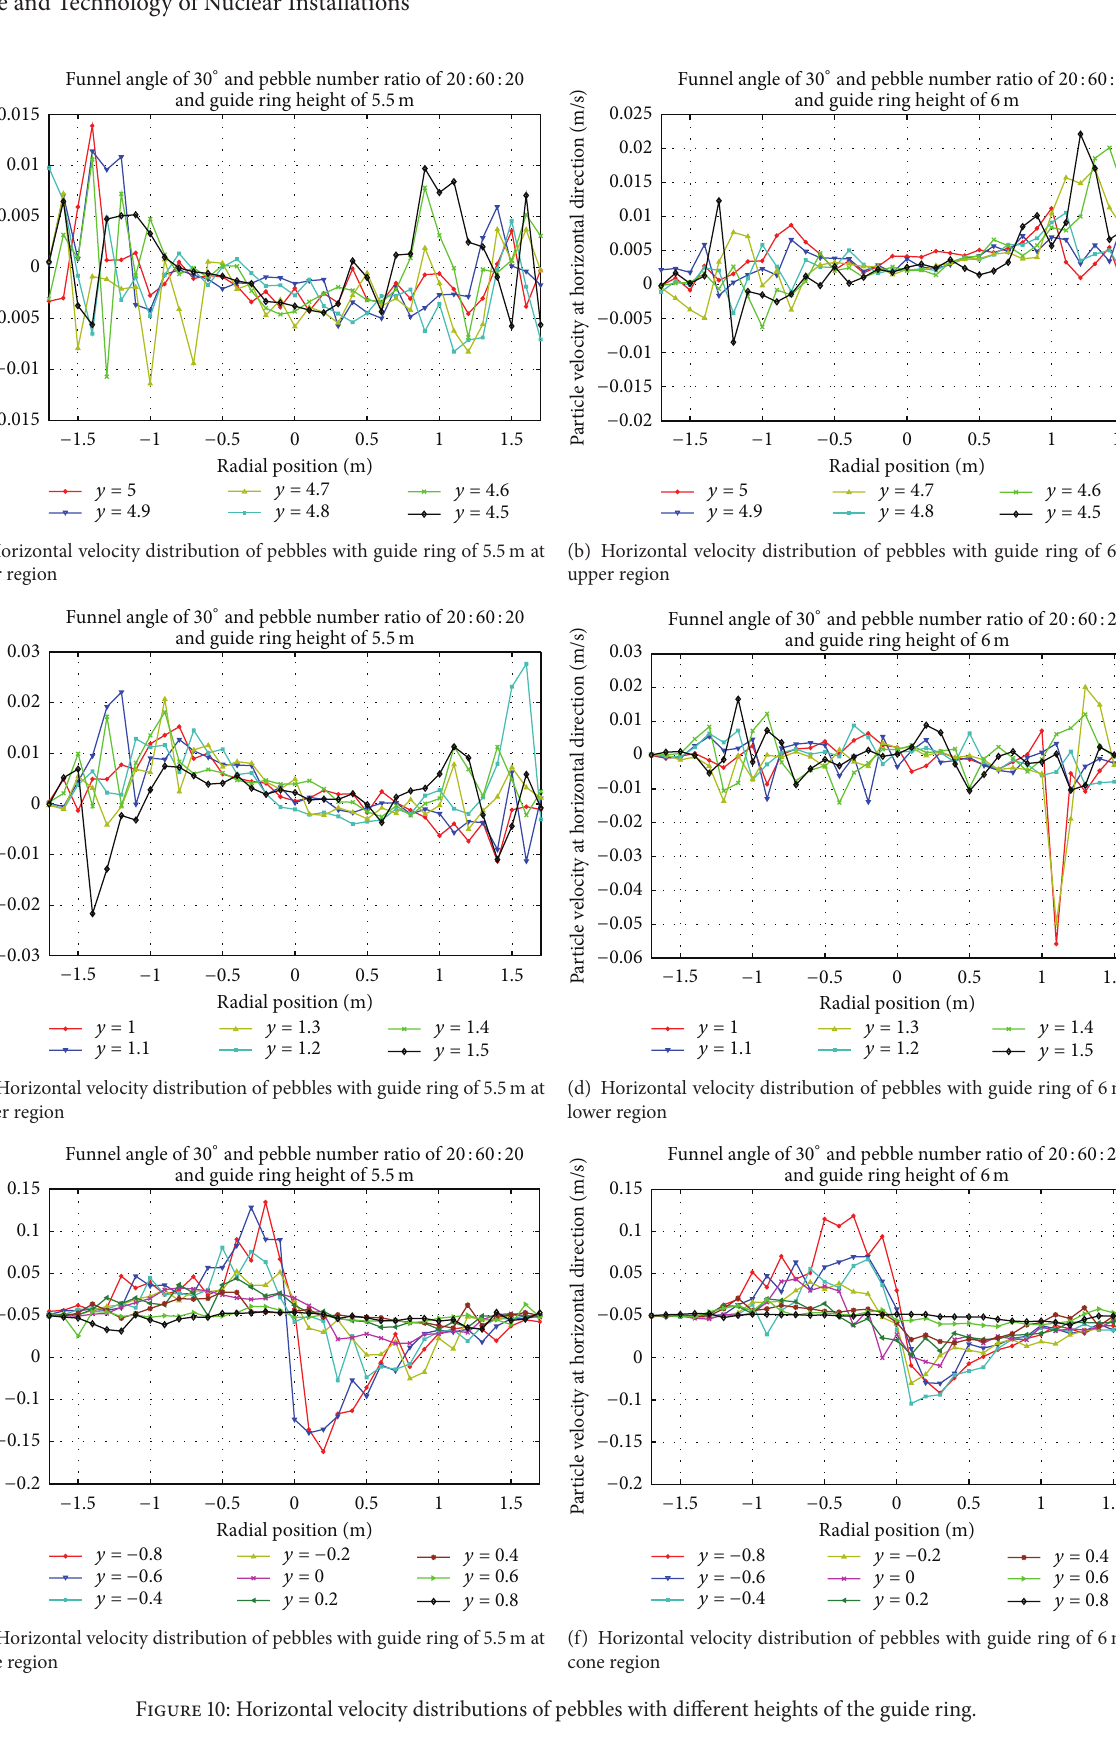
mFunnel angle of 30 ∘ and pebble number ratio of 20 : 60 : 20 and guide ring height of 5.5